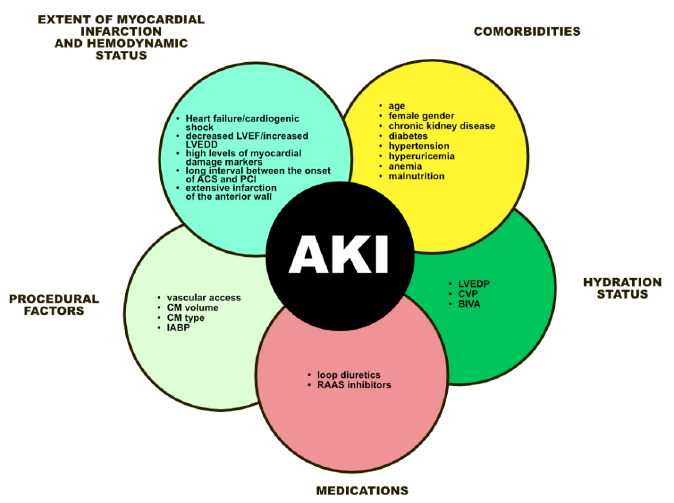
Figure 2. Diagram illustrating risk factors for AKI in patients with MI undergoing PCI AKI, acute kidney injury; LVEF, left ventricle ejection fraction; LVEDD, left ventricular end-diastolic dimension; PCI, percutaneous coronary intervention; CM, contrast media; IABP, intra-aortic balloon pump; RAAS, renin-angiotensin-aldosterone system; LVEDP, left ventricular end-diastolic pressure; CVP, central venous pressure; BIVA, bioelectrical impedance vector analysis.